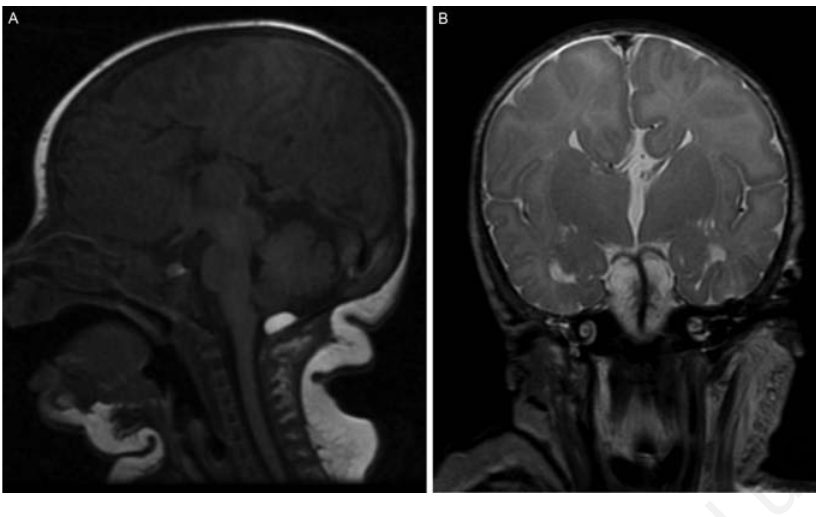
Figure 1. Brain magnetic resonance imaging. A) Midsagittal T1 FLAIR. Absence of the corpus callosum. B) Coronal T2 fast spin echo image. Typical Viking helmet or moose head configuration of the ventricles and high third ventricle extending into the inter- hemispheric